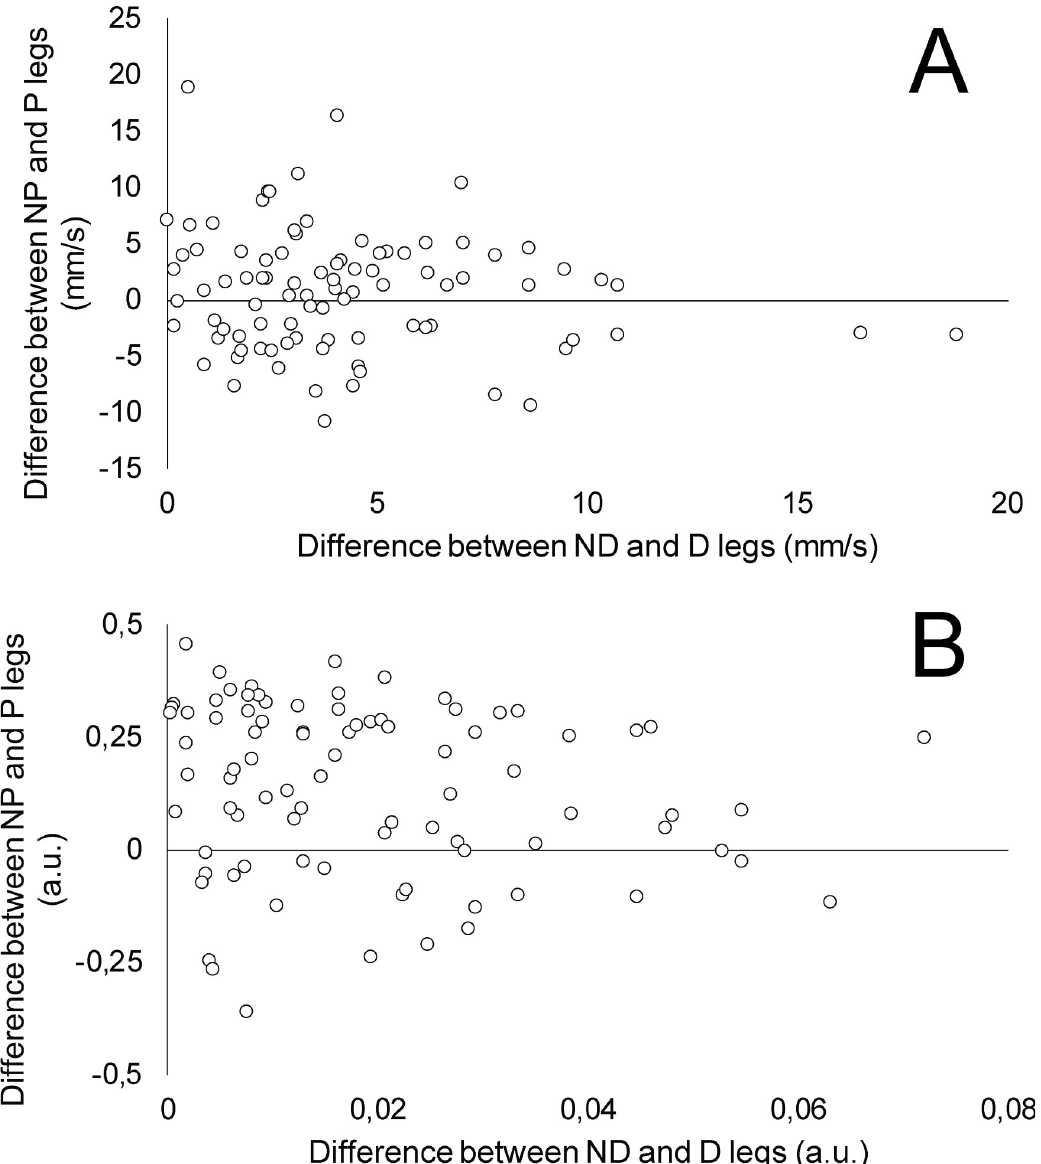
Fig 2. The relationship between the differences between the legs based on preference and dominant for CoP velocity during static balance task (A) and dynamic postural stability index B) in the dynamic task. D–dominant; ND–non dominant; P–preferred; NP–